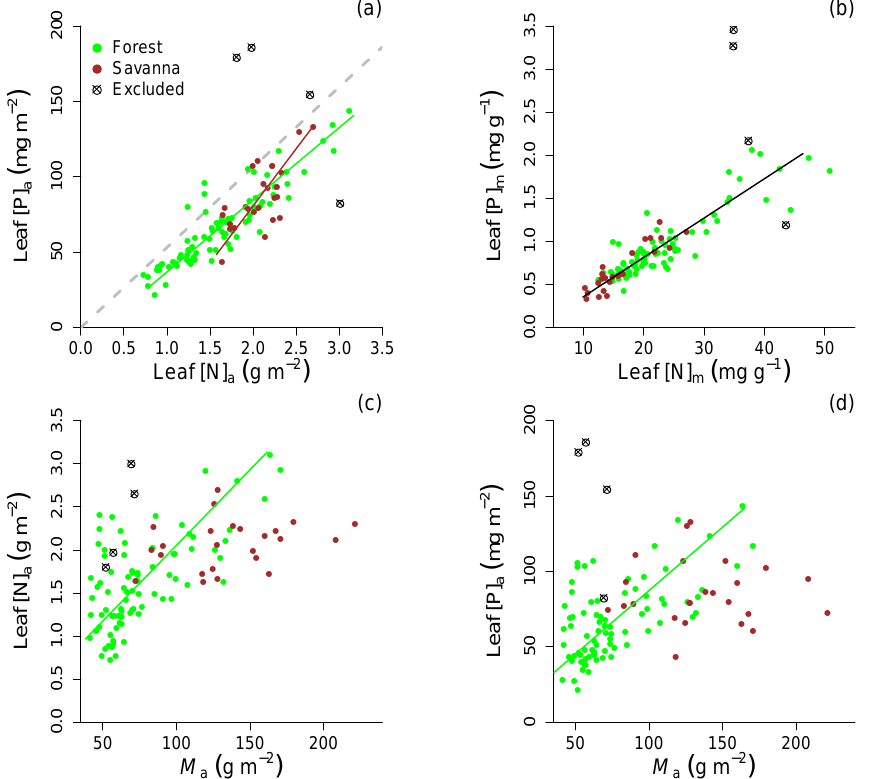
Figure 2. Scatterplots of the relationships between leaf phosphorus and leaf nitrogen (a) on an area basis and (b) on a mass basis. Plot (c) shows the relationship between leaf nitrogen on an area basis and leaf mass per unit area; plot (d) shows the equivalent relationship for leaf phosphorus. Each point corresponds to a single tree and vegetation types are distinguished by colour: green for F and brown for S . SMA- fitted lines are shown for the two vegetation types only where the bivariate relationship proved significant p < 0 . 05. Pearson correlations testing the assumption of linearity are given in Table S4 together with the likelihood ratio and Wald statistics testing the H 0 of common slope, elevation and axis shift for the two V classes. Intercept, slope and r 2 values for the SMA-fitted lines are given in Table 3. In plot (a) a third fitted line (grey, dashed) displays a slope based on a mean N:P ratio of 18.8 typical for tropical forests as reported by Reich et al. (2009) and passing through the origin. In plot (b) there is a common slope to the [P] m ↔ [N] m relationship for both vegetation types (black line). In reviewing residual plots of initial SMA fits (not shown), four data points were identified as outliers (crossed circles). The four outliers have been excluded from the rerun SMA fits shown